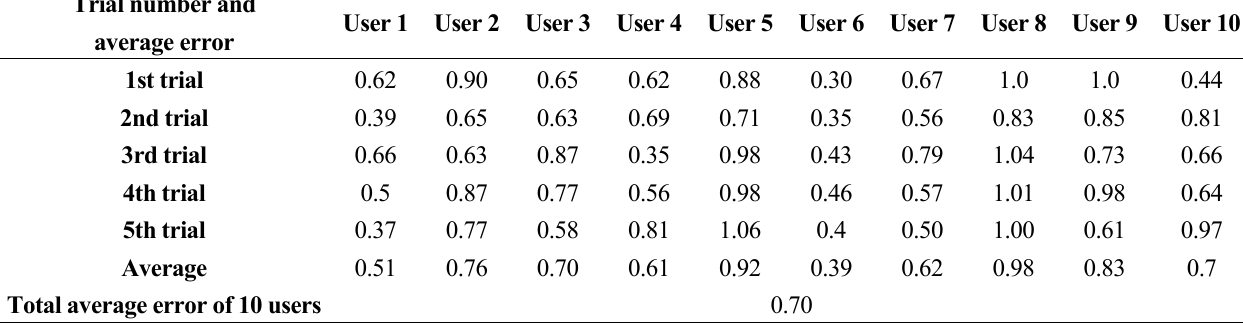
Table 3. The errors in gaze detection for cases where the users were not wearing glasses (units: °). Trial number and average error